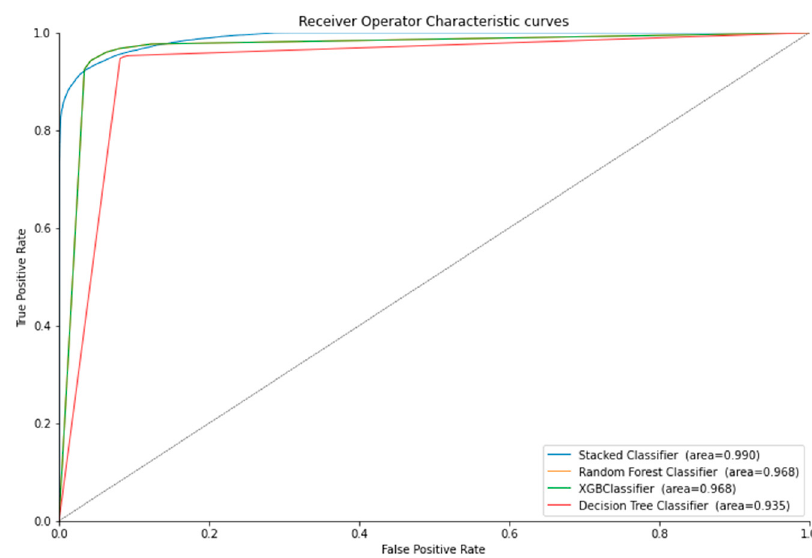
Figure 4. The ROC curve for the UNSW dataset.